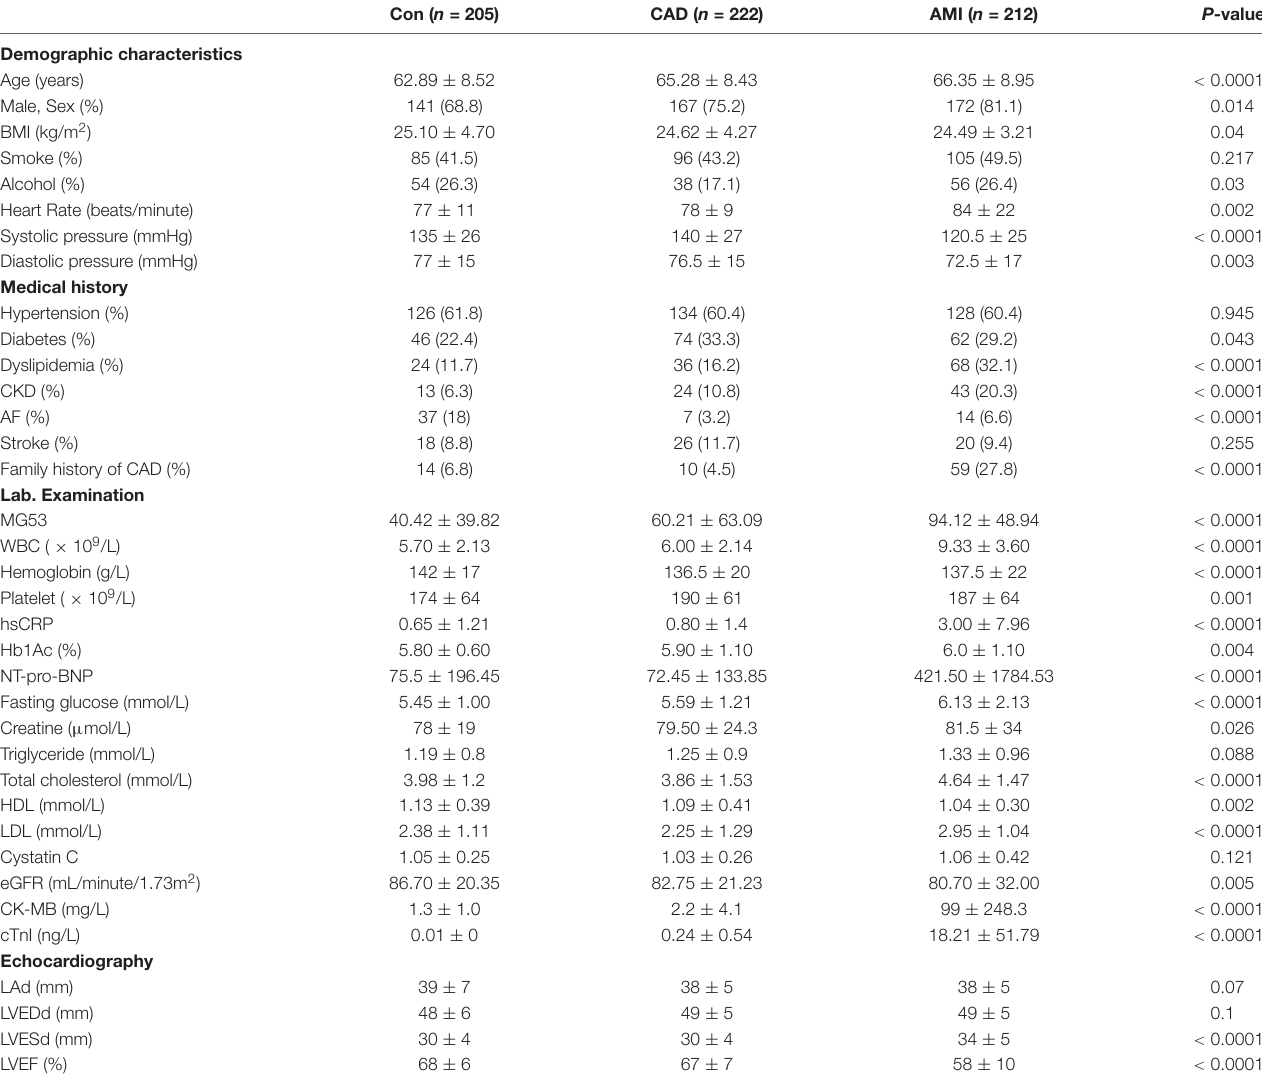
TABLE 1 | Baseline characteristics of all